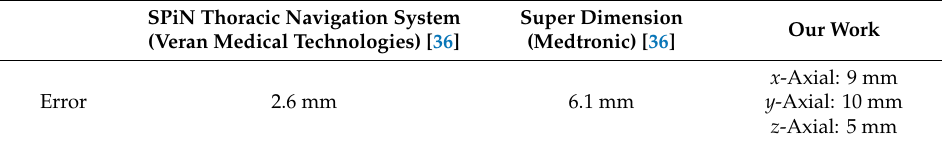
Table 2. Comparison of errors of commercial and our electromagnetic targeting